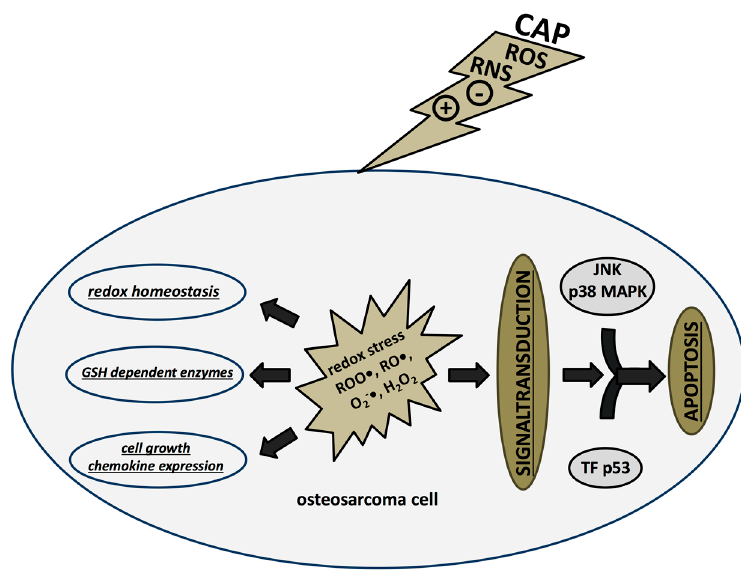
Figure 2. CAP effects on osteosarcoma cells. CAP, cold atmospheric plasma; reactive oxygen species (ROS), reactive nitrogen species (RNS), glutathione (GSH), transcription factors (TF), c-Jun N-terminal kinases (JNK).